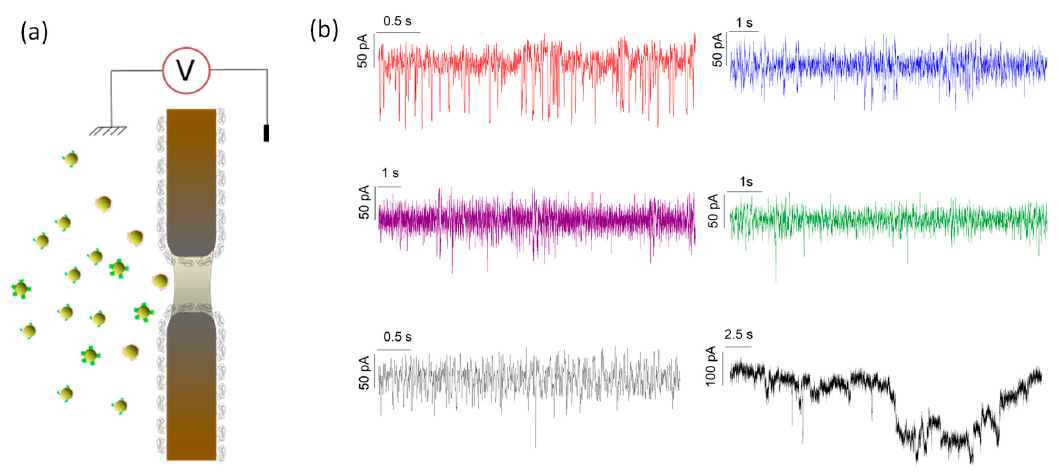
Figure 2. ( a ) Illustration of the nanopore sensing experiment ( b ) examples of current traces obtained from avidin-AuNP (red), BSA-AuNP (blue), peroxidase-AuNP (purple), glucose oxidase-AuNP (green), β -lactoglobulin-AuNP (black).